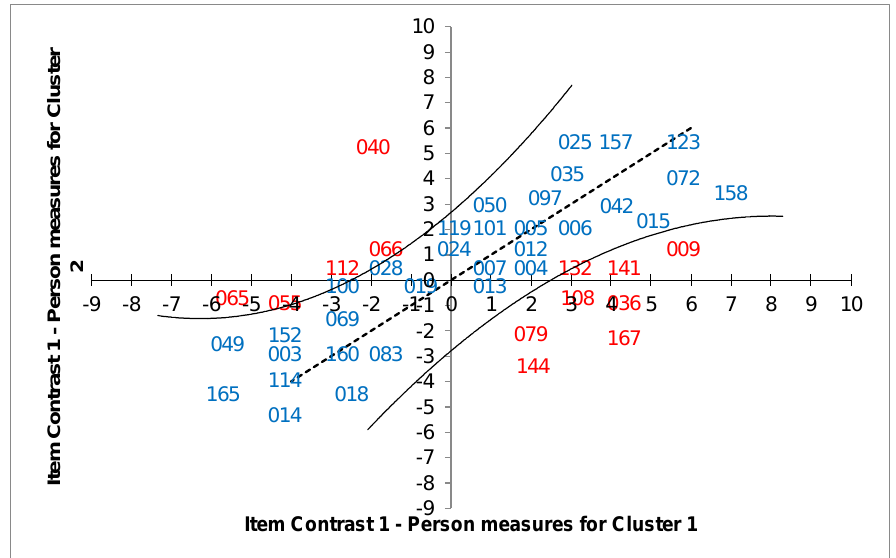
Figure 1 Item Contrast 1 - Person measures for Clusters 1 and